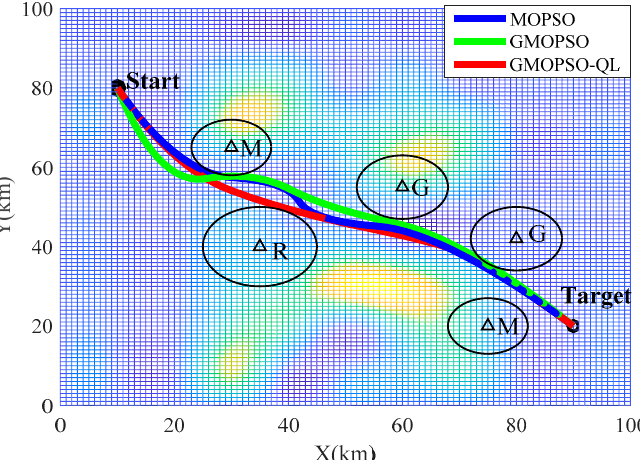
Figure 3. Plane view of the best flight paths in Case 1.